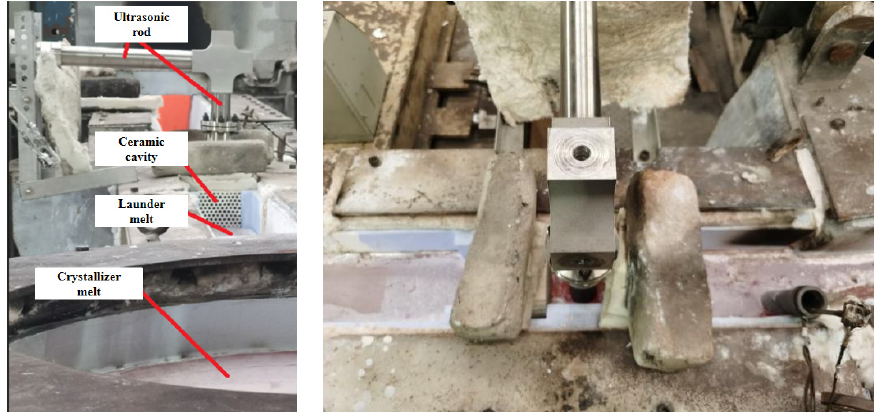
Figure 2. Online ultrasonic purification of launder melt site